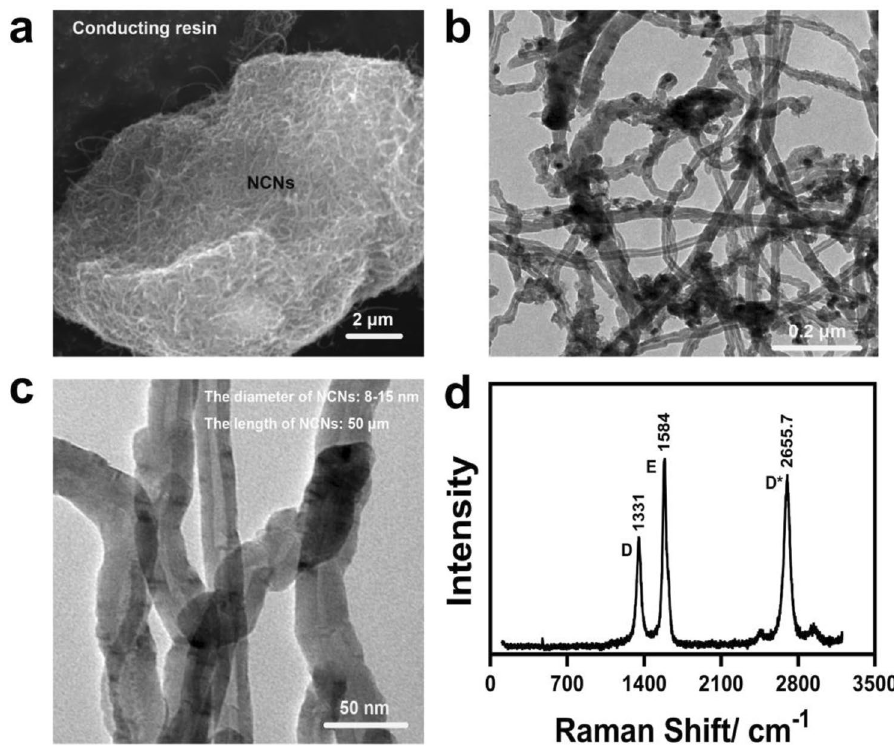
Figure 1. The morphology, size and Raman spectra of NCNs (OriginPro 2018, https:// www. origi nlab. com/ index. aspx? go= Produ cts/ Origin; Adobe Illustrator CS5, https:// www. adobe. com/ cn/ produ cts/ illus trator. html# scroll).